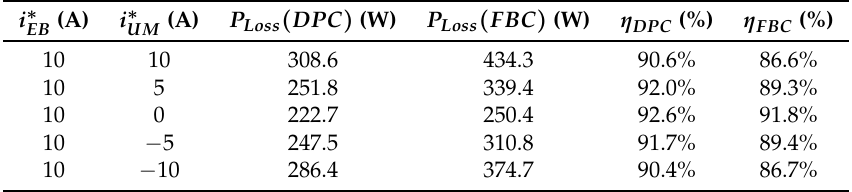
Table 3. Experimental losses and efficiency performance of DPC and FBC